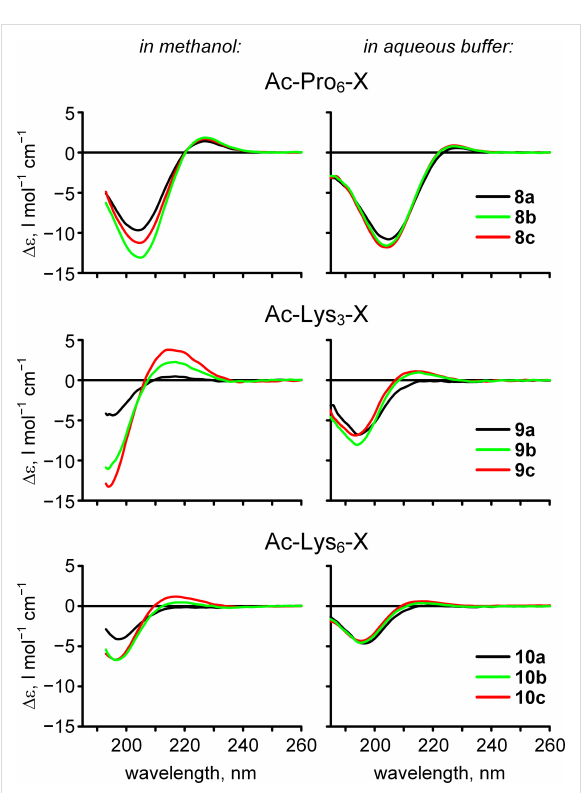
Figure 5: Mean residue molar circular dichroism ( Δε ) of peptides 8 – 10 in methanol (left) and aqueous phosphate buffer (right, 50 mM buffer, pH 7.0) samples. Recorded at 298 K and 100 μ M